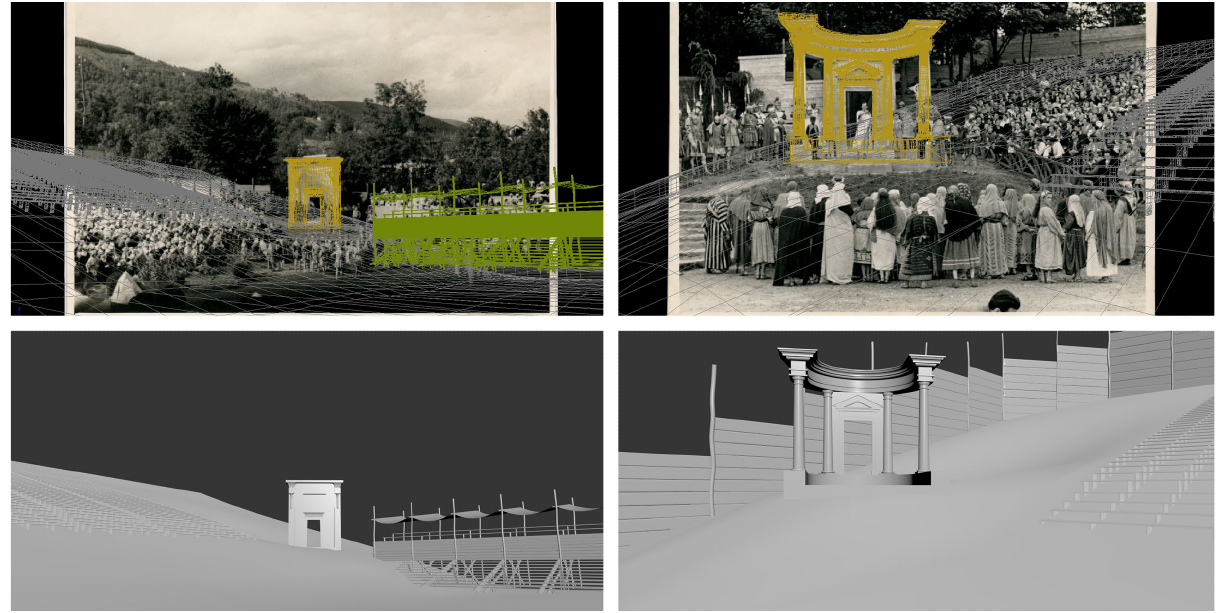
Figure 11 . Camera matching between historical pictures and 3D models. ©